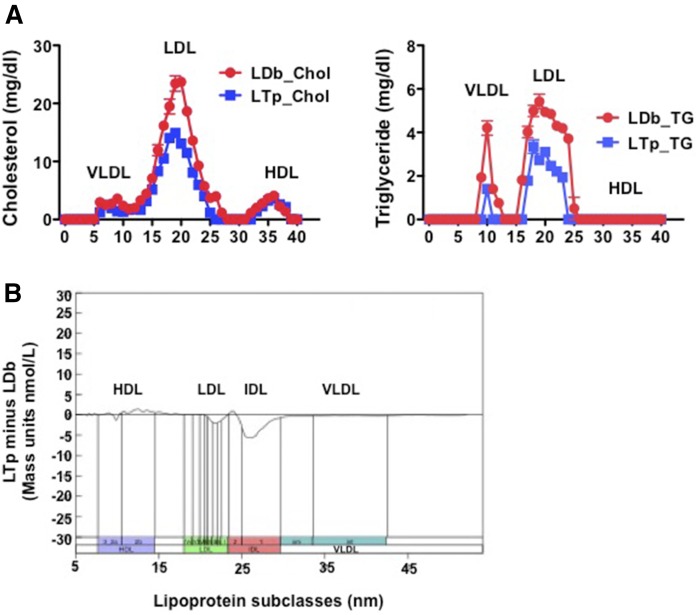
A: Profiles of plasma lipoproteins separated by FPLC. Pooled equal volume (50 μl) plasma samples from LDb (n = 5) and LTp (n = 5) mice at 5 months of age were fractionated by FPLC. The concentration of TC (in milligrams per deciliter) and TG (in milligrams per deciliter) of each fraction was determined. The figure shows the average of three different pooled plasma FPLC runs; each pool contains five animals and the total is 15 animals per group for three separate FPLC runs (LDb, circles; LTp, squares; mean ± SEM). B: Plasma lipoproteins separated using IM analyses. IM analysis was used to separate lipoprotein subclasses from mouse plasma at 5 months of age between LDb (n = 3) and LTp (n = 3) mice. The plot displays the differences in particle concentrations (in nanomoles per liter) across the full lipoprotein size range after conversion of particle to mass concentrations (19); the y axis uses an arbitrary mass scale. The absolute mass concentration of each subclass and statistical analysis are presented in Table 1.